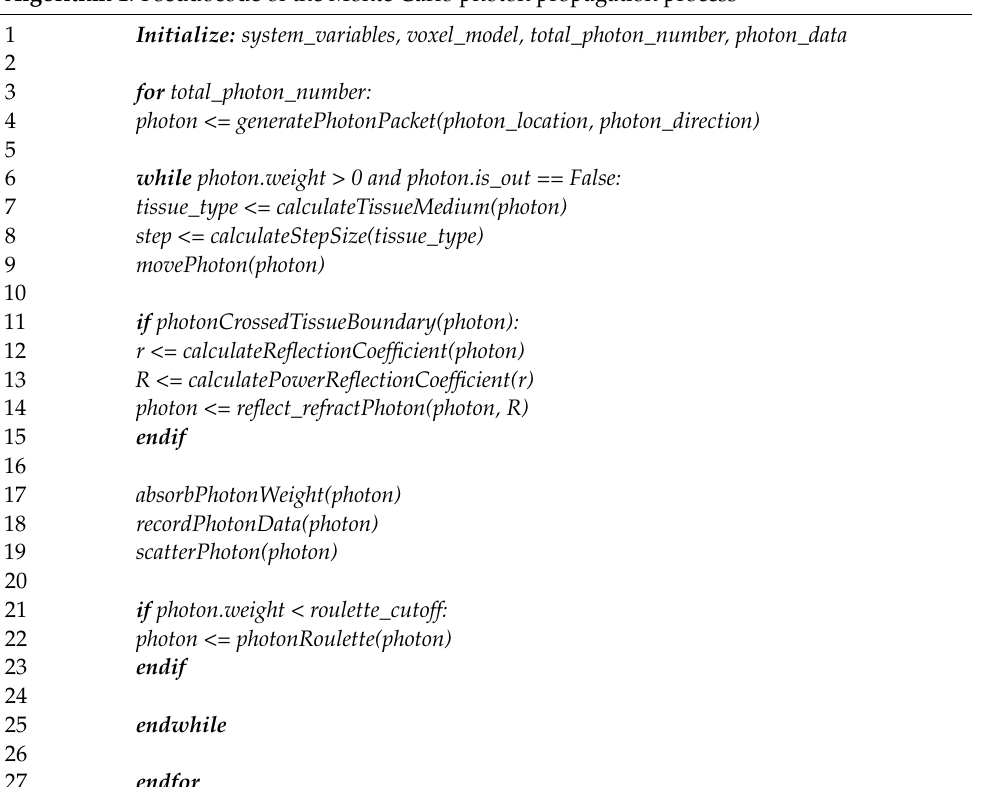
Algorithm 1 : Pseudocode of the Monte Carlo photon propagation